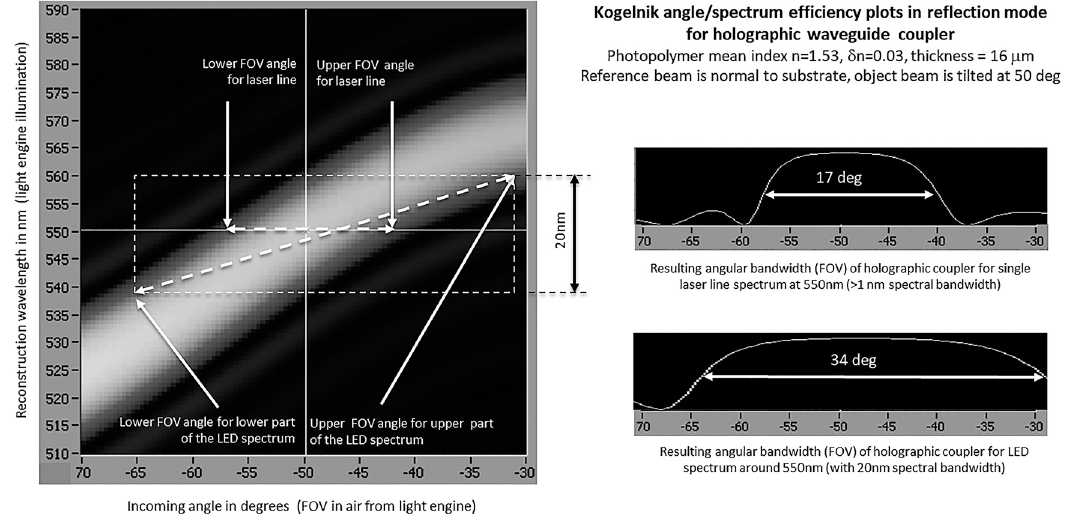
Figure 19: Spectral source bandwidth building larger FOV (angular bandwidth) for photopolymer volume holographic coupler in waveguide